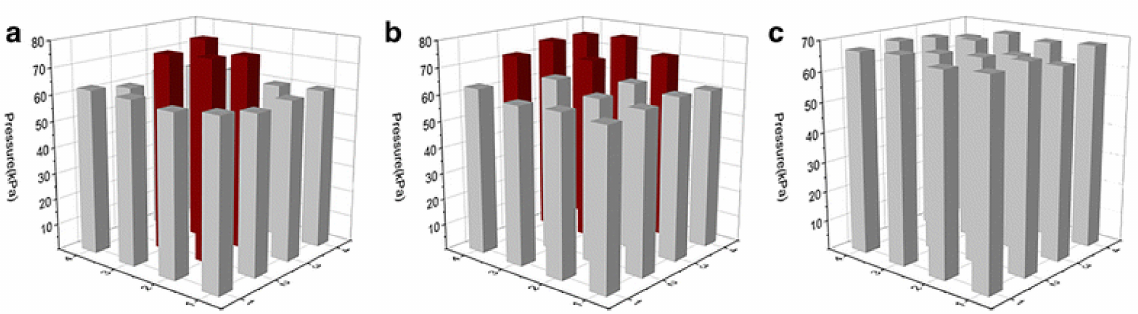
Figure 5. The state of pressure and distribution of movement of the thumb, characterized by the proposed sensor: ( a ) shiatsu, ( b ) kneading and ( c ) rubbing